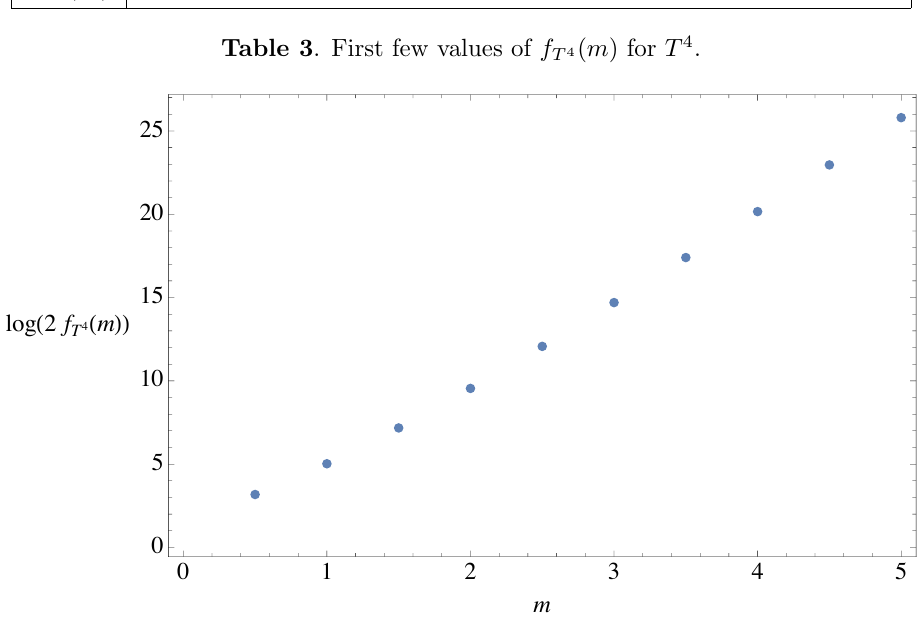
Figure 3 . A plot of log (2 f ( m )) up to m = 5 for T 4 . Note the exponential growth in m T 4